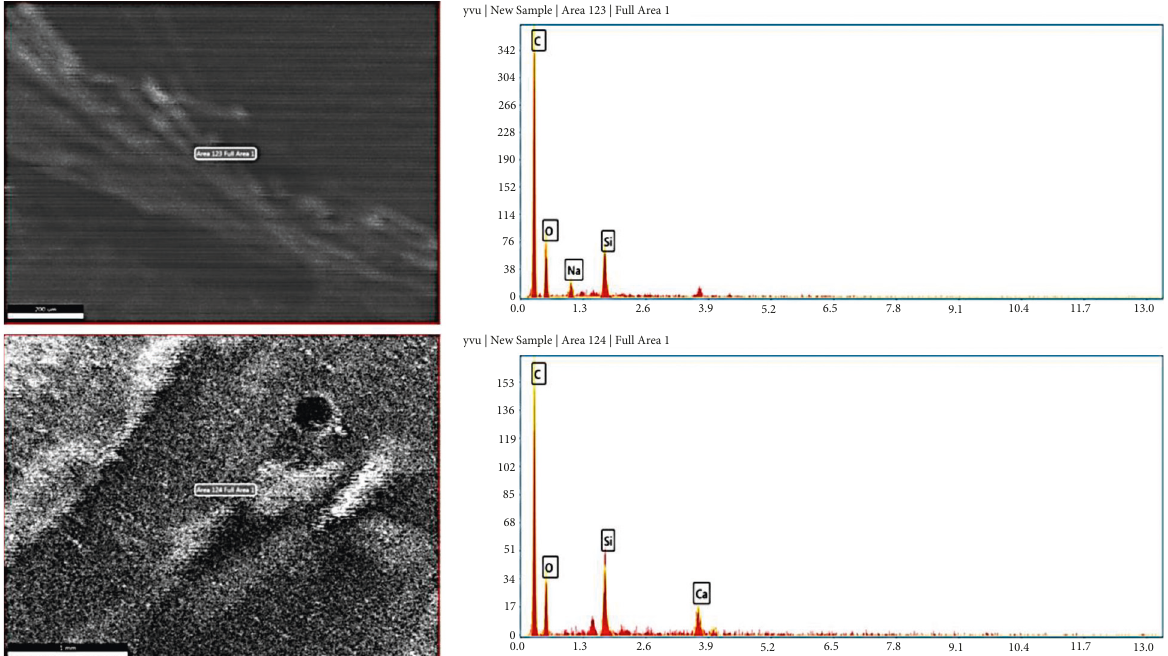
Figure 12: EDS of solid jet abrasion test for neat GFRP.